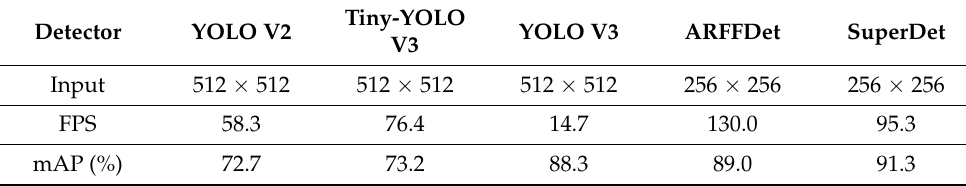
Table 5. Comparative results of each detector on the DOTA dataset. Detector YOLO V2